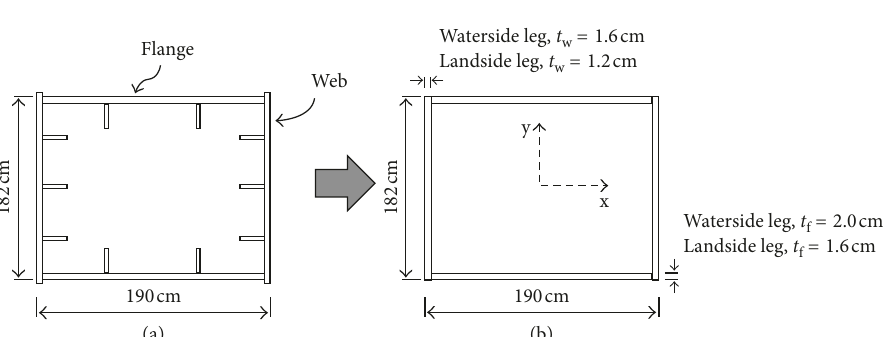
Figure 8: Hollow box elements: (a) original stiffened section and (b) simplified unstiffened